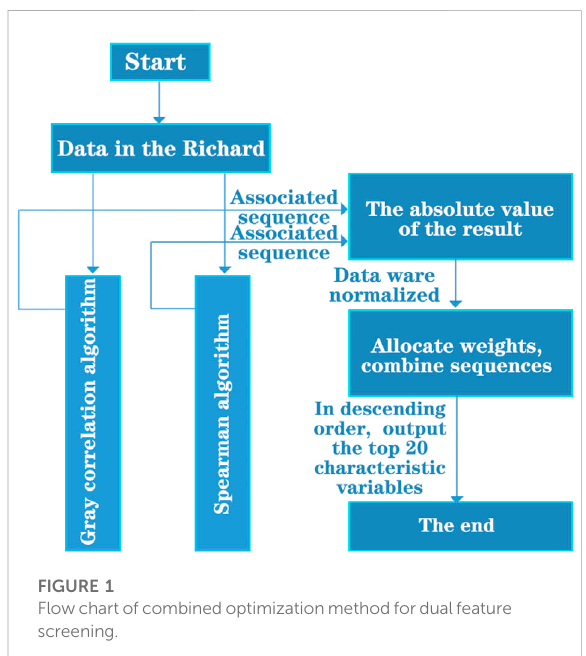
FIGURE 1 Flowchartofcombinedoptimizationmethodfordualfeature